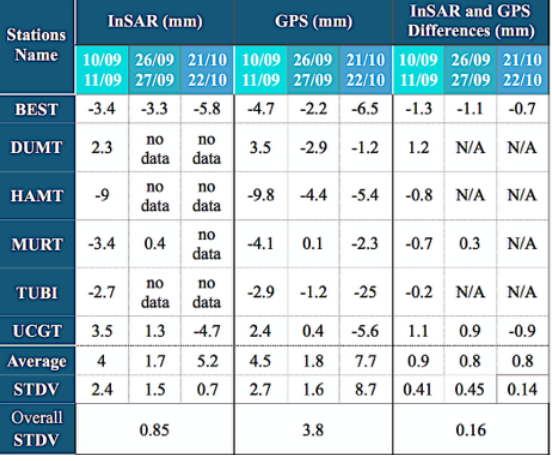
Table 3: Comparison between LOS from InSAR and GNSS results at CGPS